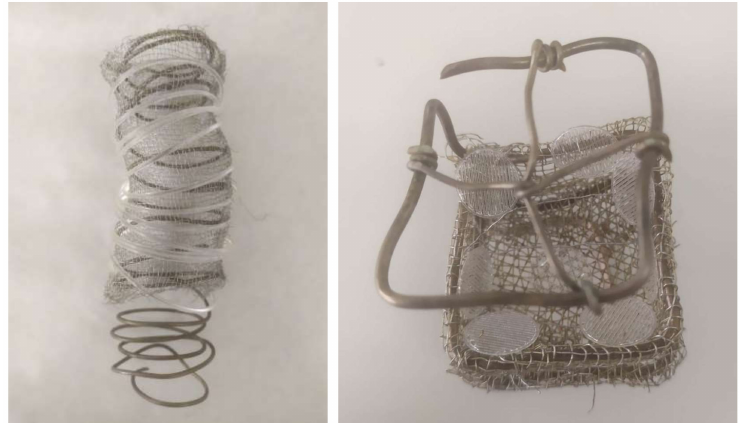
Figure 2. Polymer metal supports used over the impregnation